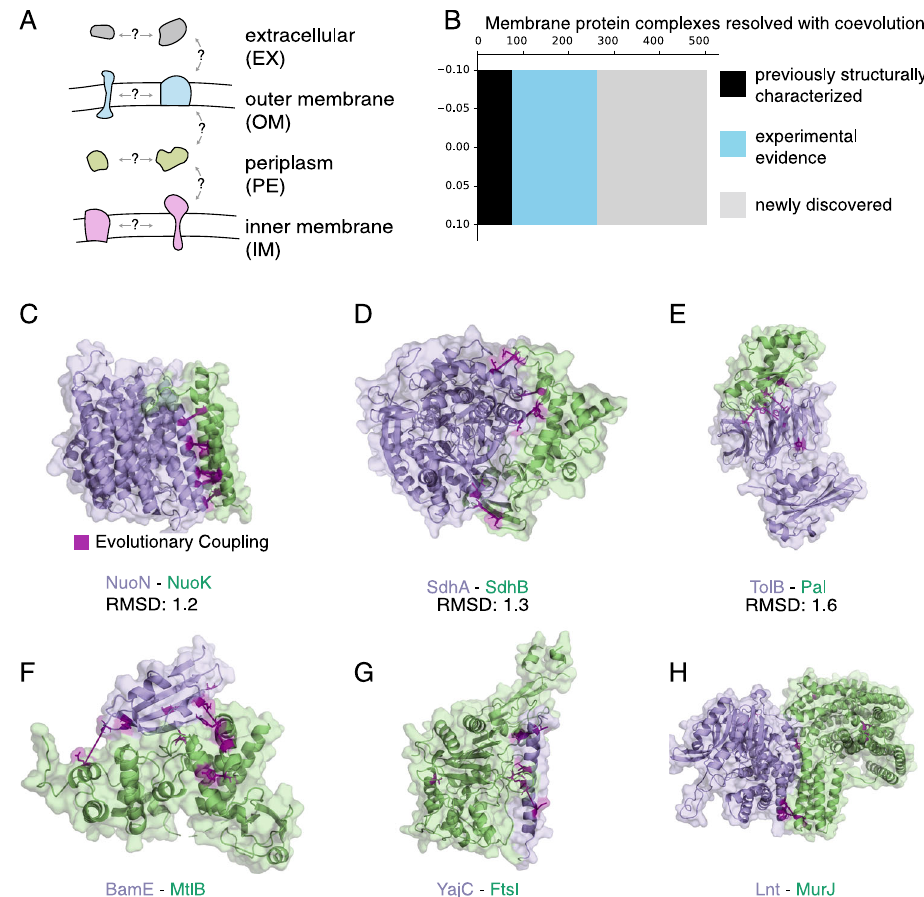
Fig. 3 Discovery of hundreds of new interactions in the E. coli membrane proteome. A We searched a high-value subset of the 10 ∧ 7 possible interactions in the E. coli proteome by searching membrane compartments with themselves and with adjacent membrane compartments. B We found 504 high-scoring protein interactions in the cell envelope, including 75 with structural characterization and 186 with previous experimental evidence (and no structural characterization). C – E 3D con fi gurations of previously structurally characterized interactions are accurately predicted by molecular docking with inferred restraints. RMSDs calculated by comparison to known structures with PDB IDs 3RKO [https://www.rcsb.org/structure/3RKO], 2WU2